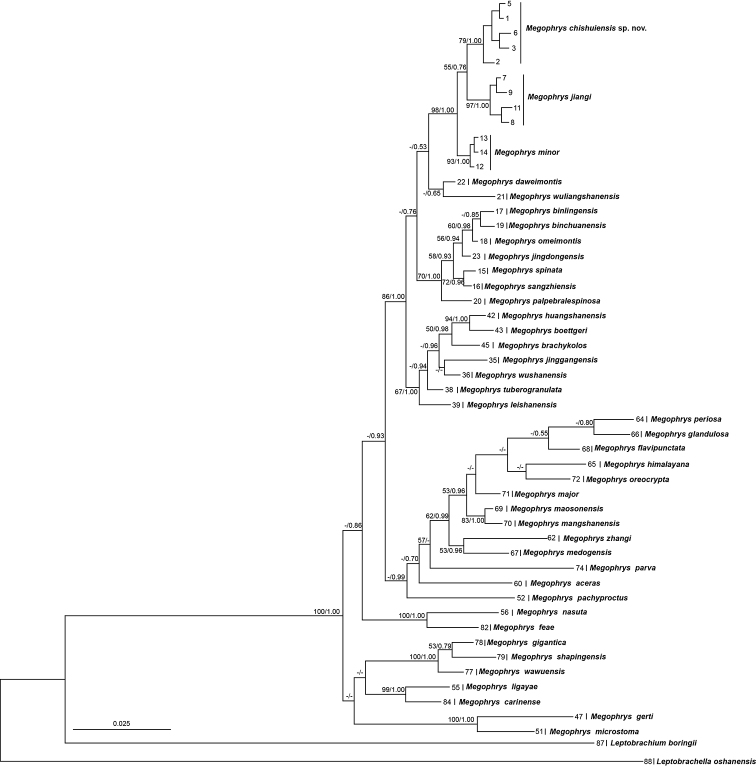
Maximum likelihood (ML) tree of the genus Megophrys reconstructed based on the nuclear DNA sequences of RAG1 and BDNF genes. Bayesian posterior probability/ML bootstrap supports were denoted beside each node. Samples 1–88 refer to Suppl. msterial 2: Table S2.